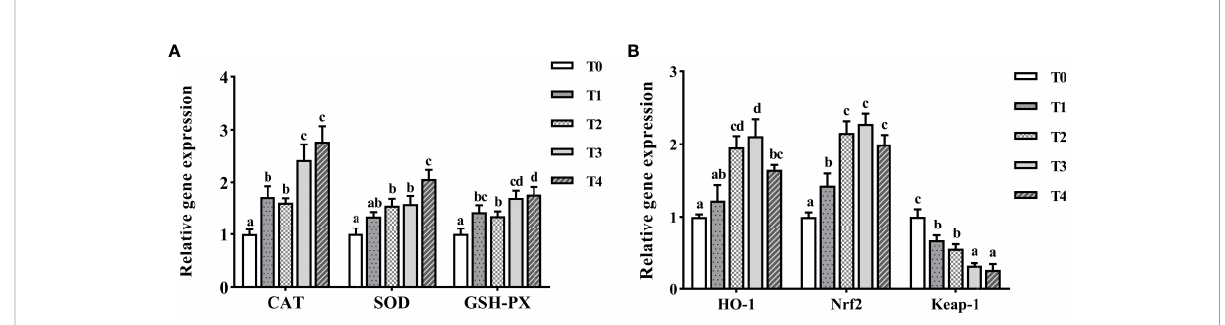
FIGURE 7 The expression pro fi les of antioxidant genes (A) and signaling pathway (B) in the intestine of T. ovatus fed diets with different dose taurine supplementation after 8 weeks. Mean values (n = 9) within values in the picture above with different superscripts are signi fi cantly different ( P <